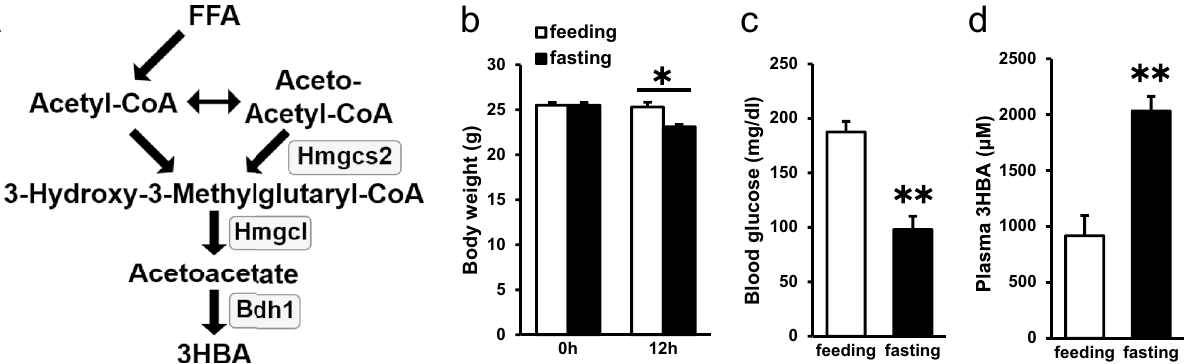
Figure 1. Ketone body 3HBA was physiologically regulated. ( a ) Schematic representation of ketone body metabolism. FFA, free fatty acid; Hmgcs2, 3-hydroxy-3-methylglutaryl-CoA synthetase; Hmgcl, 3-hydroxy- 3-methylglutaryl-CoA lyase; Bdh1, β-hydroxybutyrate dehydrogenase; 3HBA, 3-hydroxybutyric acid. ( b ) Body weight of C57BL/6 J mice in the feeding and fasting groups at the beginning (0 h) and end (12 h) of the experiment. n = 3. ( c and d ) Blood glucose ( c ) and plasma 3HBA concentrations ( d ) of C57BL/6 J mice after 12 h of feeding and fasting. n = 3. Data are mean ± SEM. * p < 0.05, ** p <